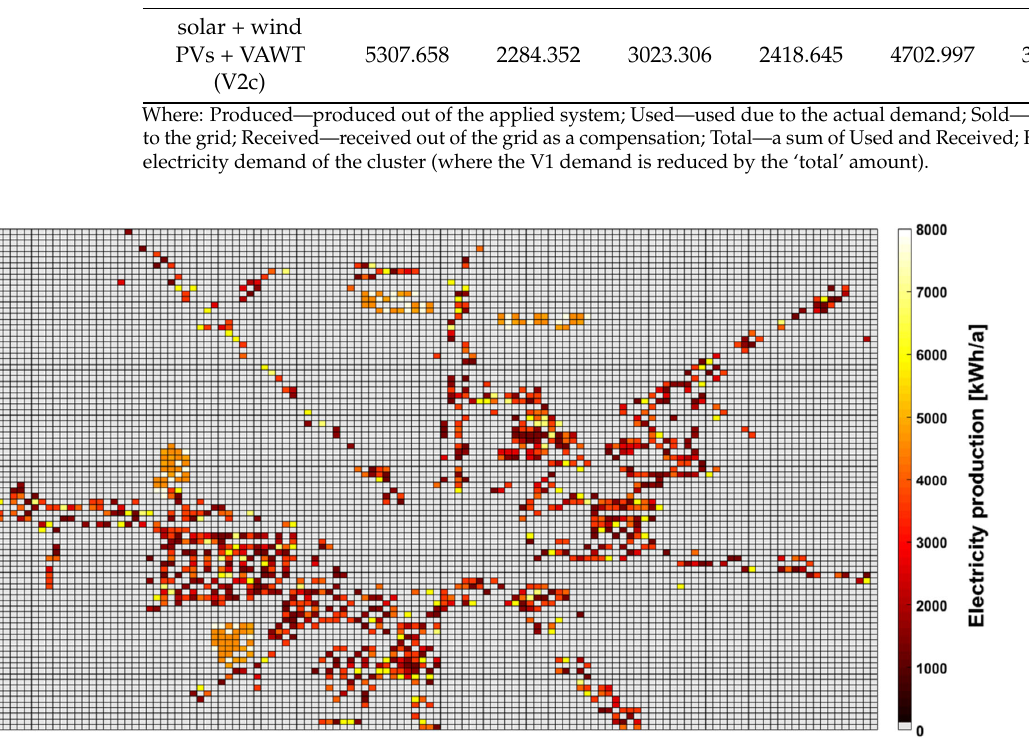
Figure 8. Solar potential map out of PVs applied in the Nowosolna cluster.